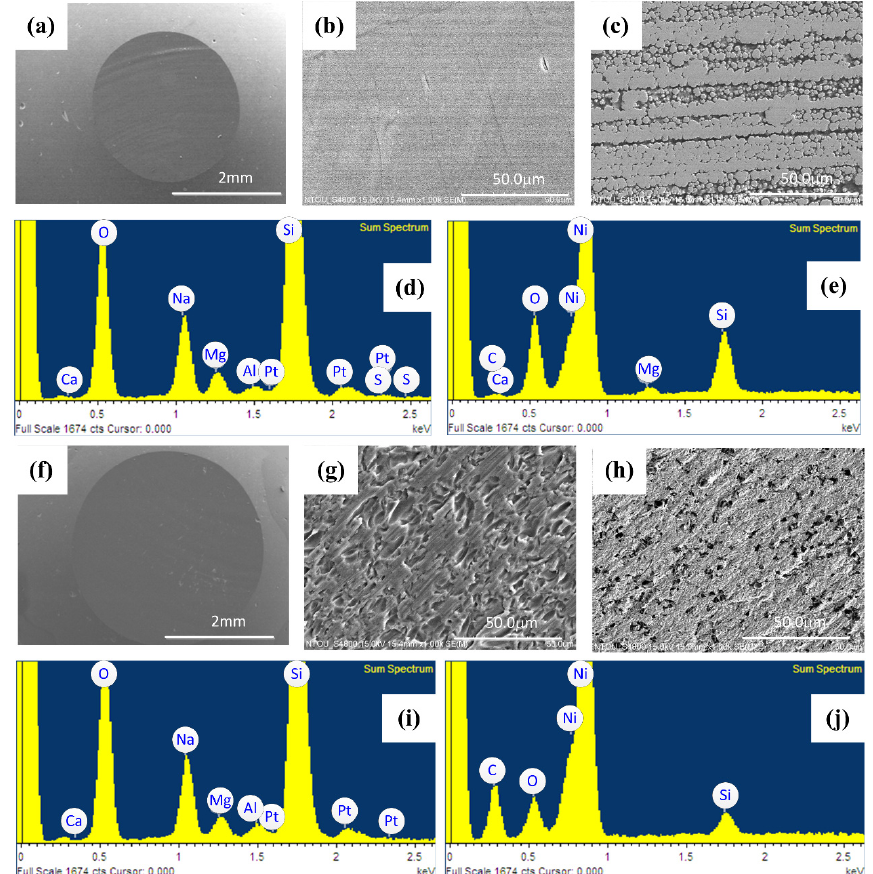
Figure 8. Results of the wear test for the Ni coating and the Ni–diamond coating. ( a ) The surface image of the glass ball of Ni coating, ( b ) the magnification of ( a , c ) the worn morphology of Ni coating. ( d , e ) the compositions of the glass balls and the Ni coatings respectively. ( f ) The surface image of the glass ball of Ni-diamond coating, ( g ) the magnification of ( f , h ) the worn morphology of Ni-diamond coating. ( i , j ) the compositions of the glass balls and the Ni-diamond coatings respectively. A glass ball was the wear counterpart. The operational parameters of the wear test were 5.88 N and 90 rpm with 4000